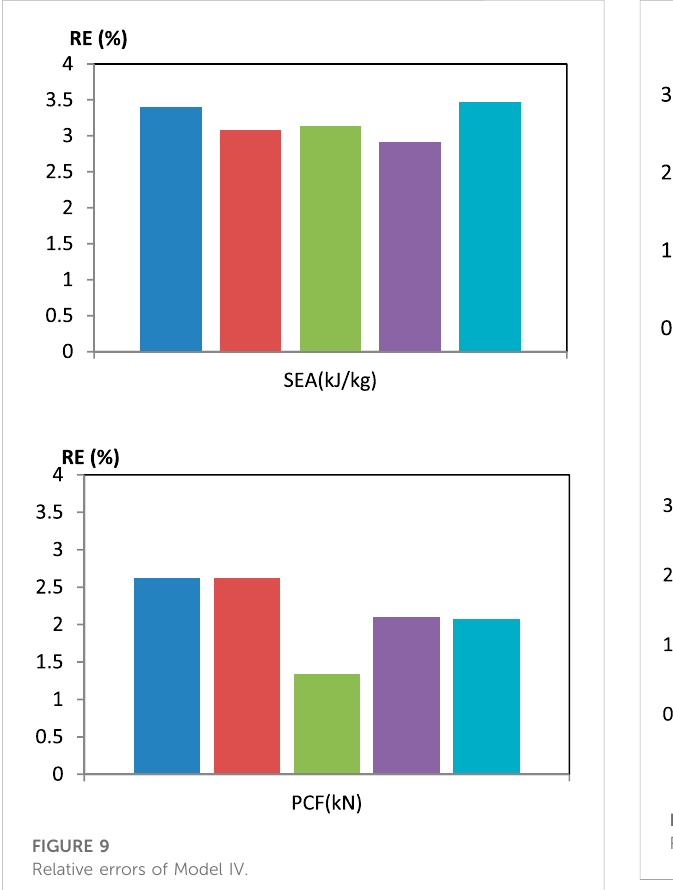
FIGURE 9 Relative errors of Model IV.